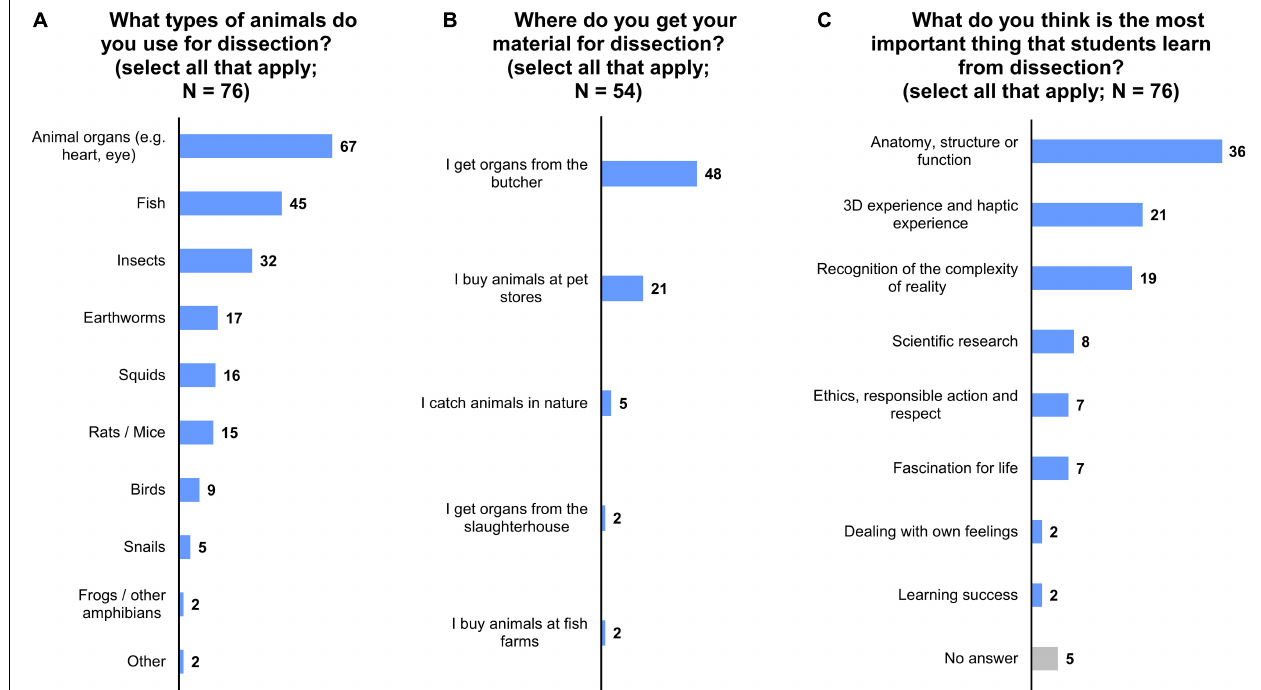
FIGURE 3 | (A) Type of animals used in dissection classes. (B) Source of animals used in dissection classes. (C) The most important learning outcome of dissection exercise.